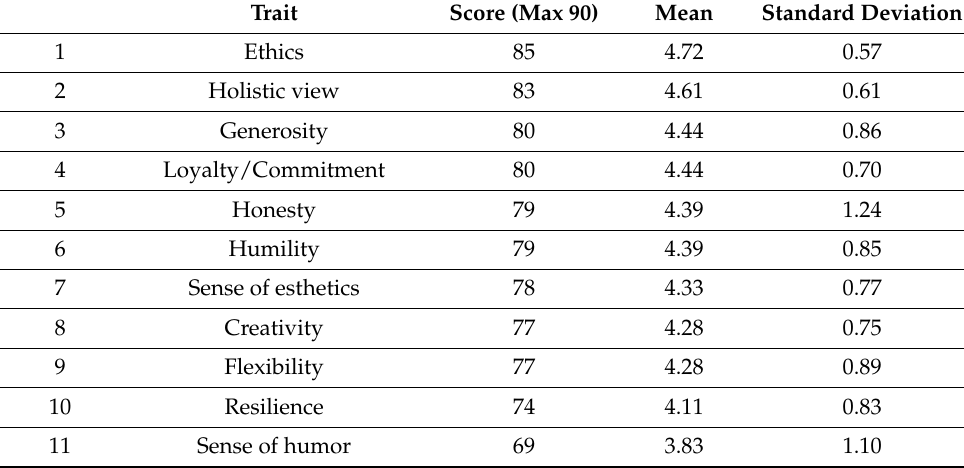
Table 5. Scores of the traits of the biomimetic leader, according to the expert panel. Trait Score (Max 90) Mean Standard Deviation 1 Ethics 85 Holistic view Generosity